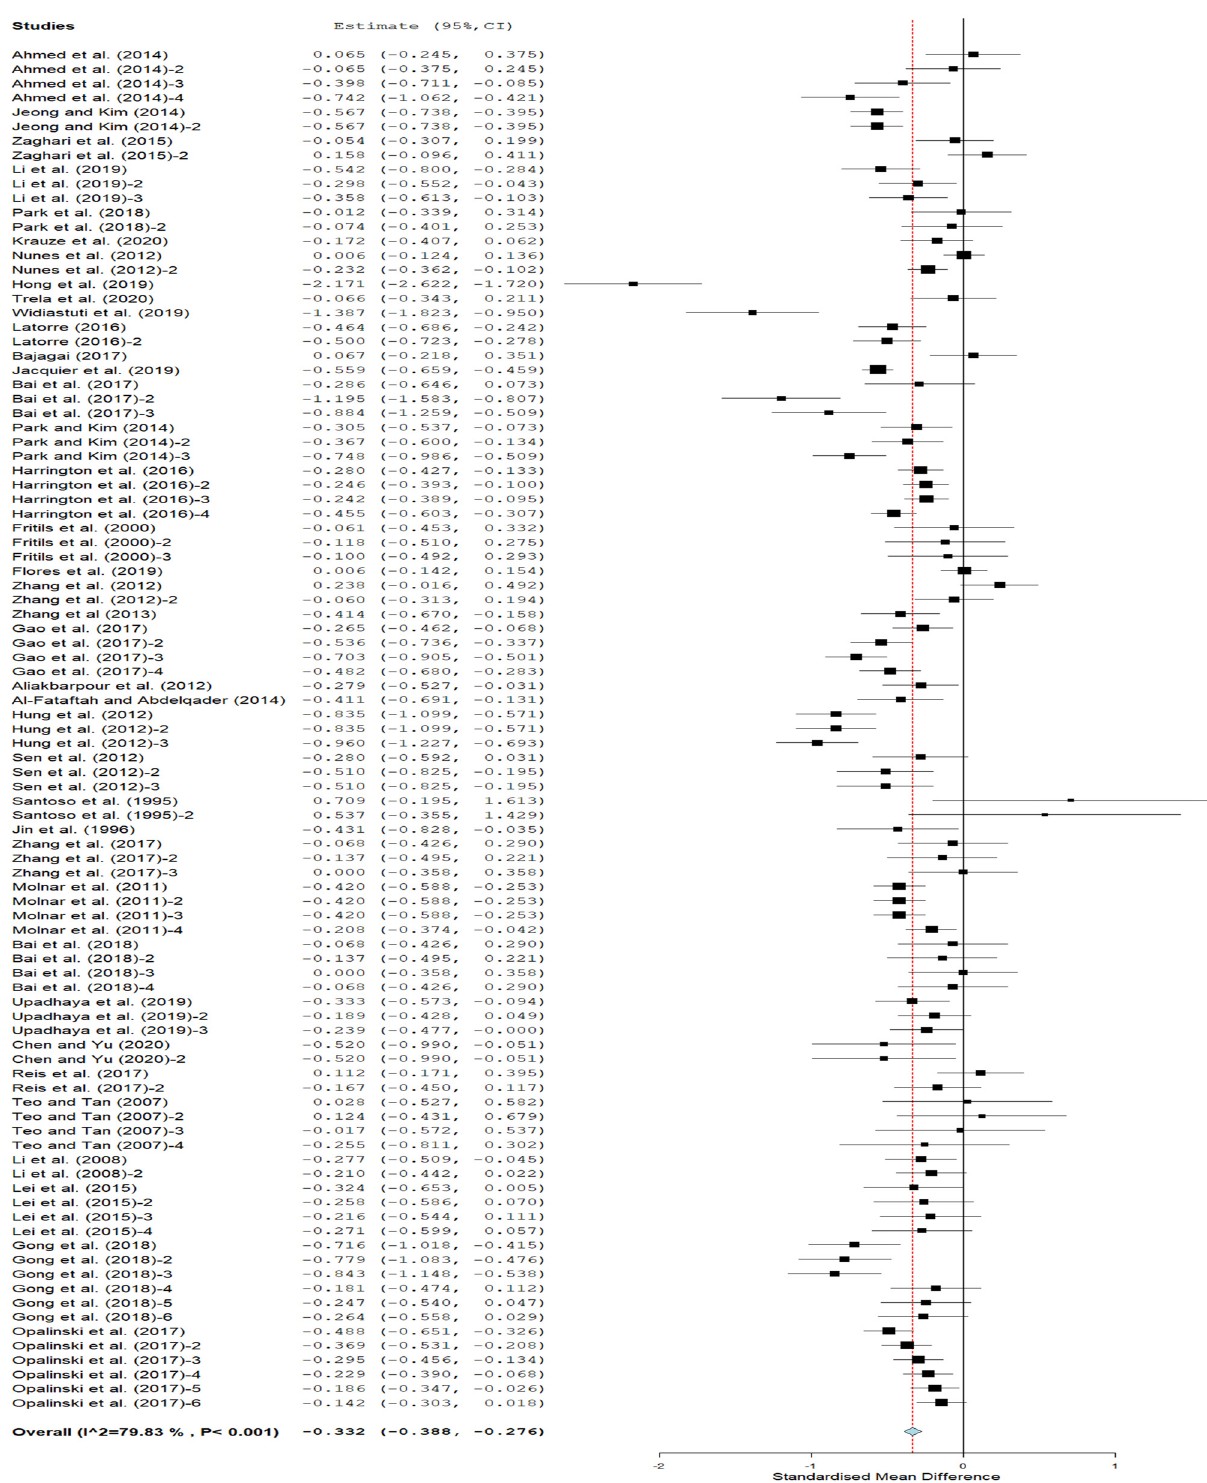
Figure 4: E ff ect of Bacillus supplementation on FCE in broiler chickens. Pooled estimation ( SMD ) = 0 ( thick line ) suggests no e ff ect, SMD > 0 suggests an increase in variables of interest over the controls and SMD < 0 denotes a decline in variables of interest over the controls. The dotted line with a diamond denotes the cumulative e ff ect size across all studies used for the meta -